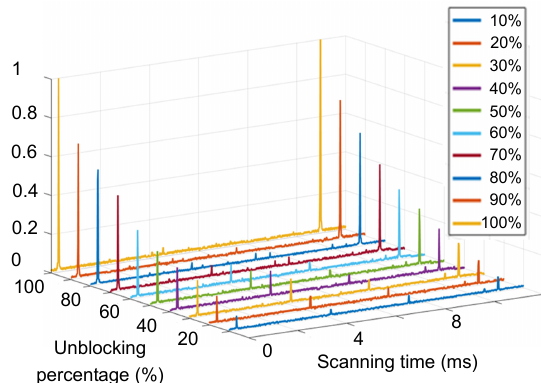
Fig. 4 | The various intensities of the transmitted light as a function of the change in the length of the Fabry-Pérot cavity as detected via a photodiode . When the unblocking percentage of the incident beams decreased, the intensity of the LG 01 peaks decreased because of the energy reassignment to other peaks.